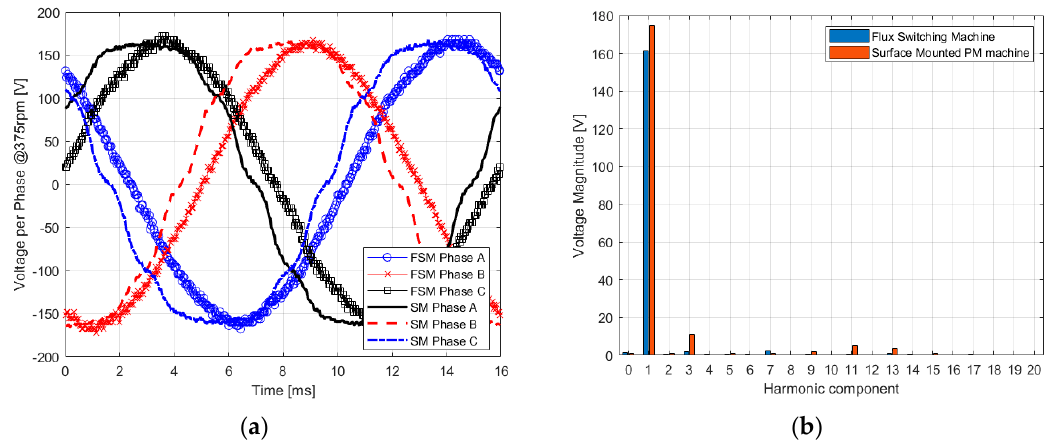
Figure 22. Comparison between the EMF generated by the surface mounted PM machine (SM) and the flux switching machine (FSM). ( a ) Measured EMF waveforms of both machines. ( b ) Frequency spectrum of the measured EMF waveforms of the two machines.